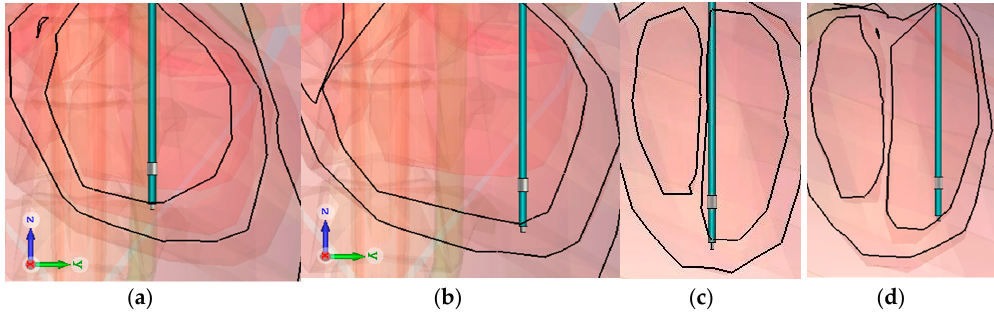
Figure 5. Implantation with the diverse position of the tip in the same chamber: ( a ) middle of the Right Ventricle in coronal view ( b ) bottom of the Right Ventricle in coronal view ( c ) middle of the Right Ventricle in sagittal view ( d ) bottom of the Right Ventricle in sagittal view. For ventricular implantations, the distance between the T-R (bipolar) varies [36–40]. A 6.7 Fr lead cable diameter and 1.4 mm helix diameter are used to amplify the helix surfaces and the impacts. These two diverse positions and the T-R distance are investigated in Table 6. Table 6. Comparison between mid and bottom RV implantation concerning induced voltages ( μ V)